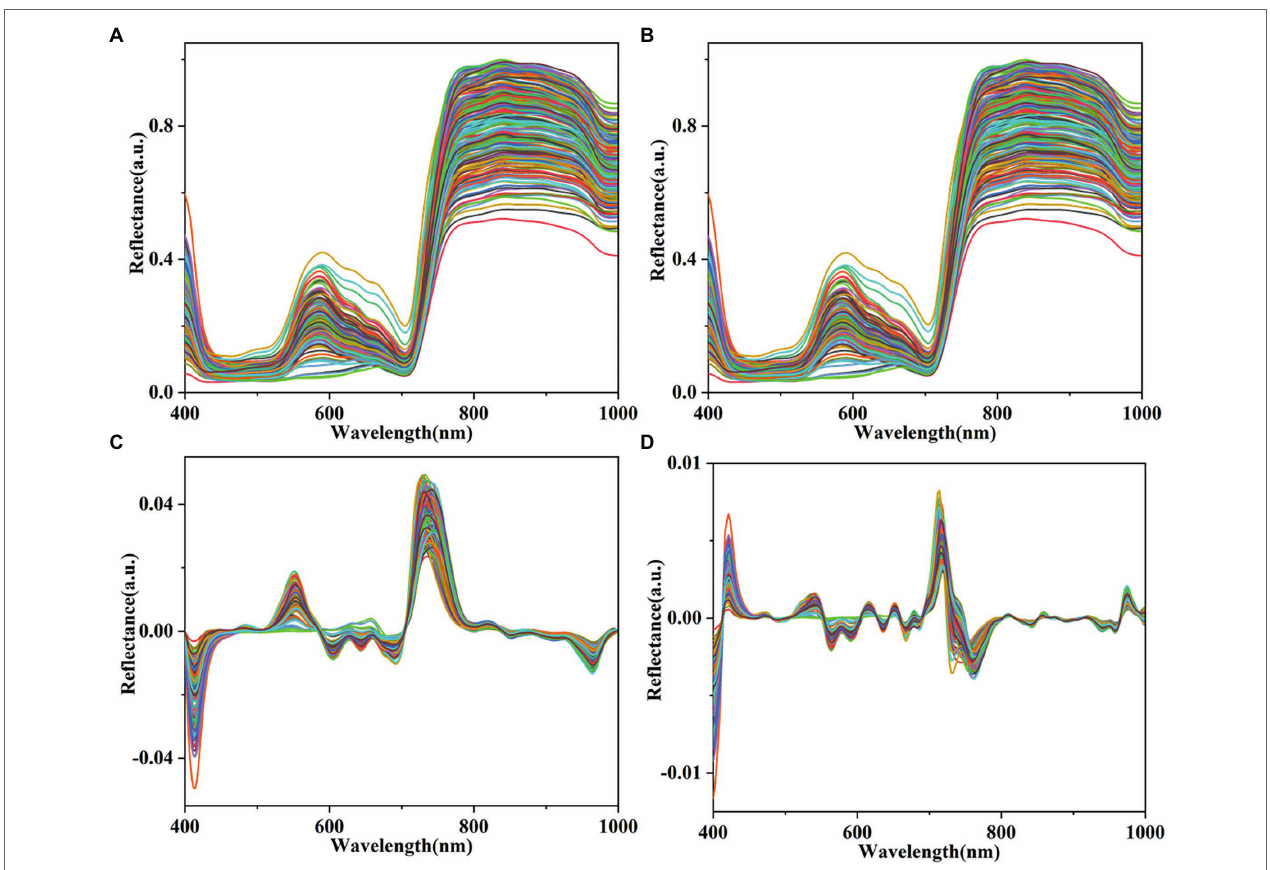
FIGURE 5 | Mean spectral reflectance of plants. (A) Raw spectra and spectra pretreated by MWS (B) , FDR (C) , and SDR (D)